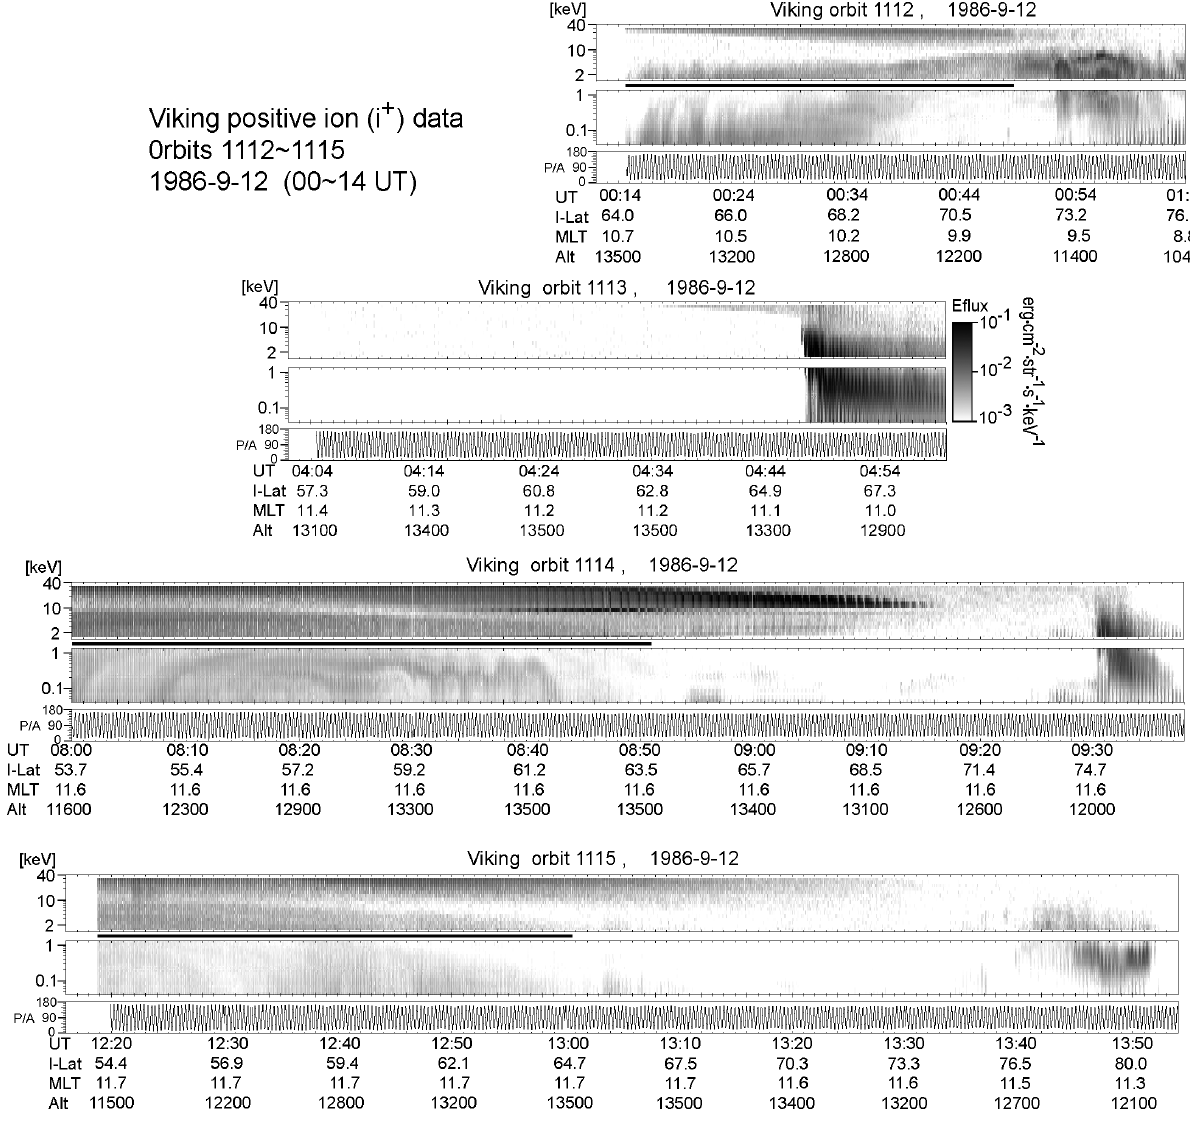
Fig. 1. Viking energy-time spectrograms for positive ions energy flux (0.05–40keV) during four consecutive traversals of the dayside ring current region on 12 September 1986 (orbits 1112 to 1115). The region with the dense trapped sub-keV ions of our interest is indicated by the thick line between